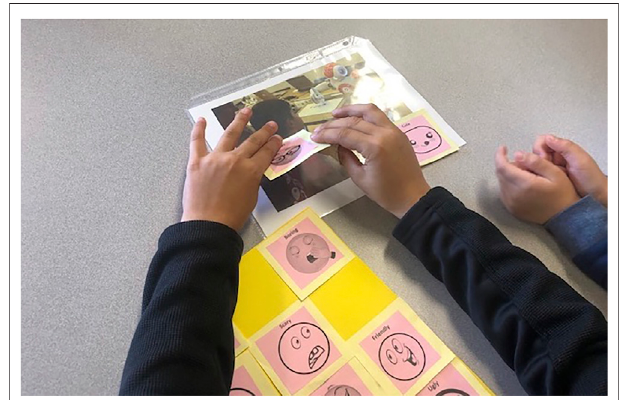
FIGURE 4 | Students labeling a robot image with emoji